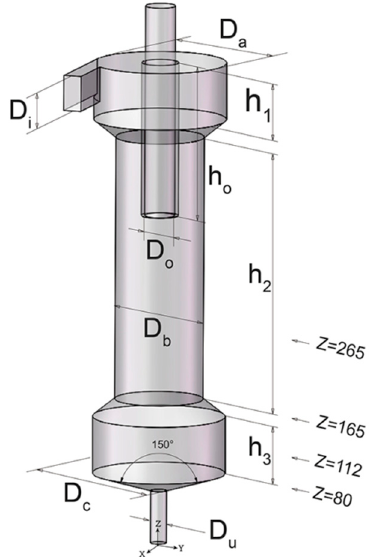
Figure 3. Structural diagram of the hydrocyclone.